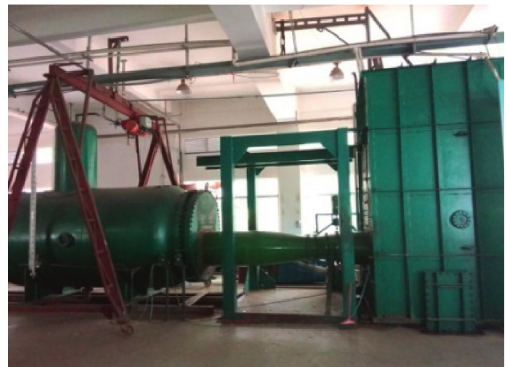
Figure 10: Photo of the multifunctional test